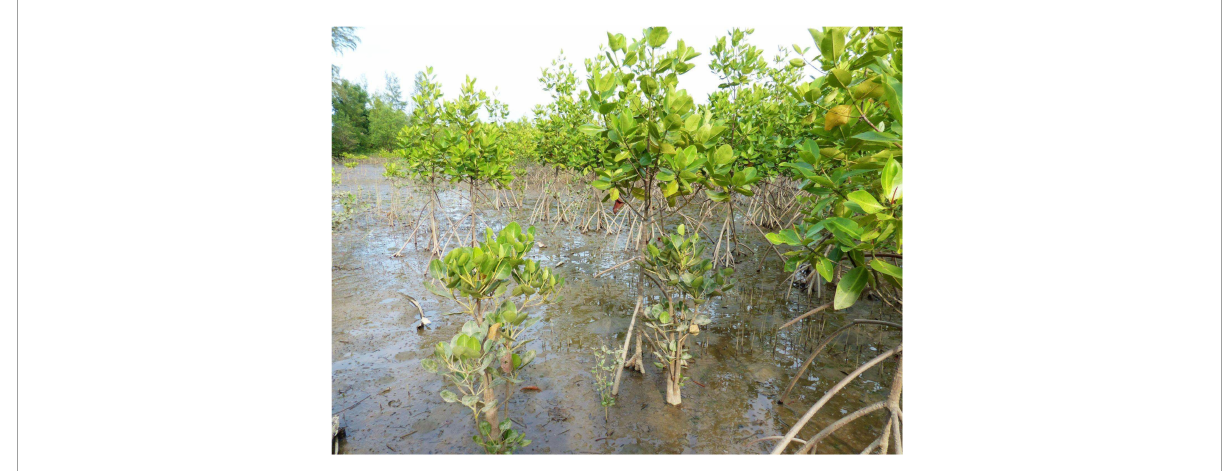
FIGURE1 Natural recruitment of the locally available Aegialitis rotundifoilia (smaller plants) after the planting of several robust Rhizophora spp. (larger plants with prop roots) by the local community (near Gwa, Rakhine State, Western Myanmar) (photograph credit: Jean